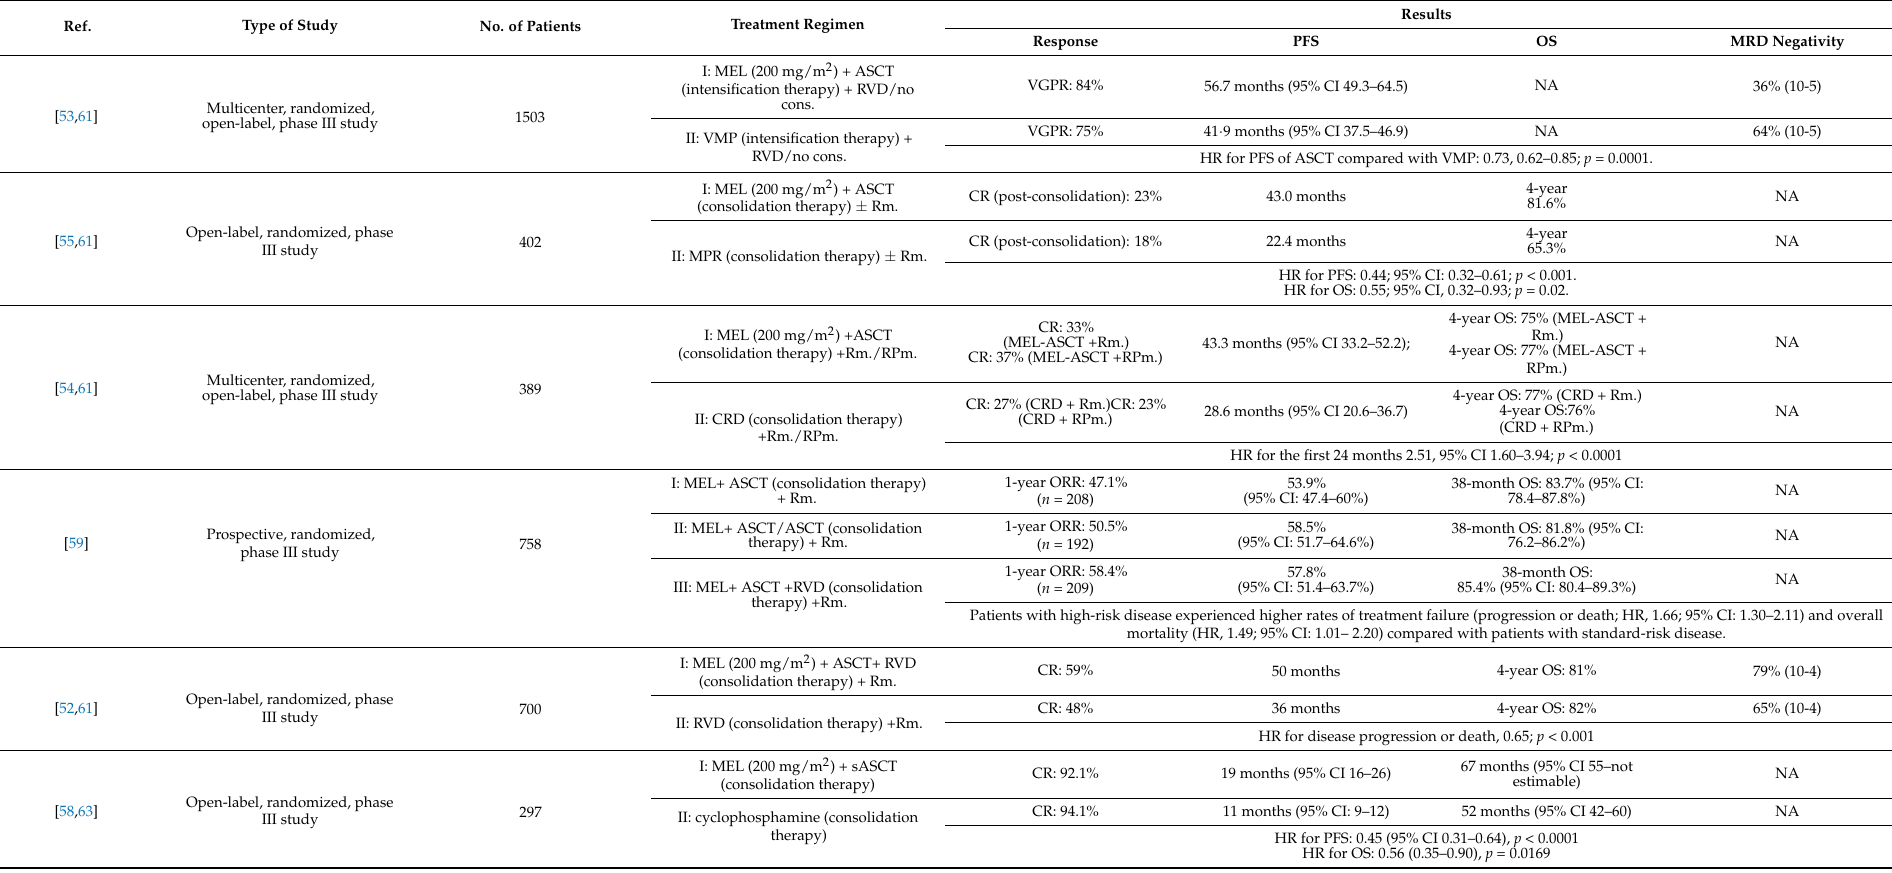
Table 1. Clinical trials assessing the efficacy of combination therapy for the treatment of MM, including melphalan-new directions. Overview of phase III clinical studies comparing the MM treatment regimen with or without Autologous Stem Cell Transplantation.